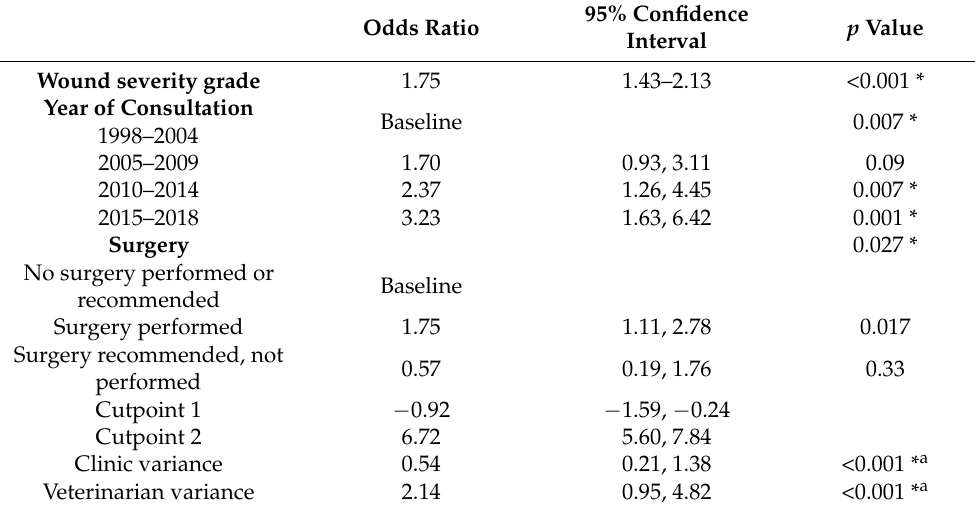
Table 5. Crossed random effects multivariable ordinal multivariable logistic regression results for prescribing an antimicrobial of higher importance for dog-to-dog bite wounds presenting for treatment from 1998 to 2018 ( n = 1405 consults, 1375 dogs, 610 veterinarians, 120